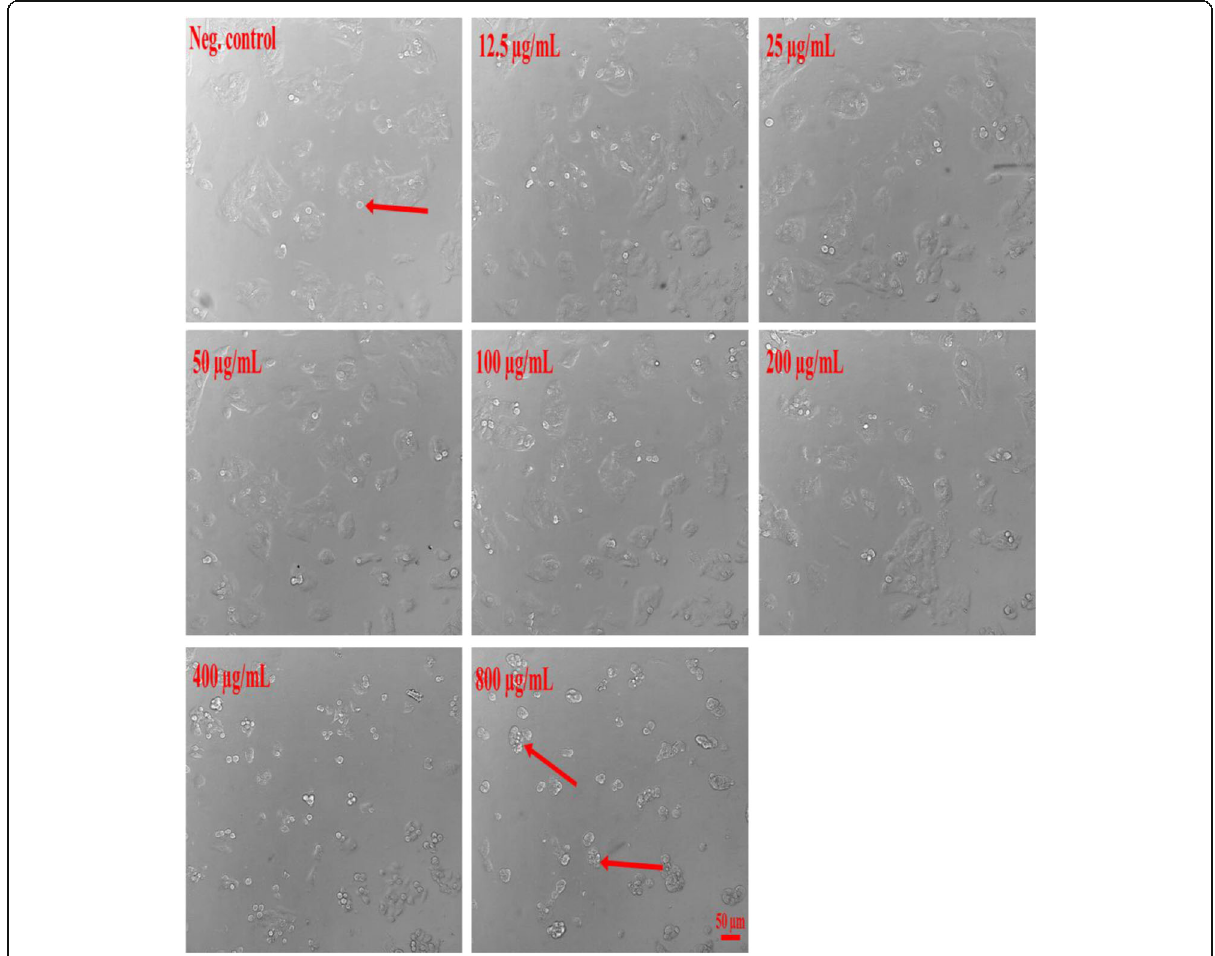
Fig. 11 Changes in HepG2 cell morphology as recorded using a widefield fluorescent microscopy. A2L-induced morphological changes in HepG2 cells after 24 h of treatment